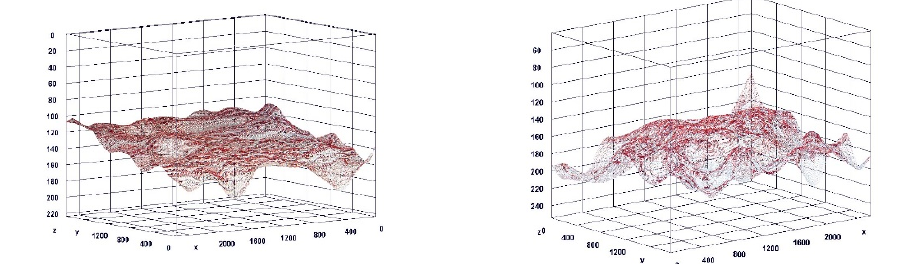
Figure 22. Visualization of the differences in elastin concentration before and after treat- ment .